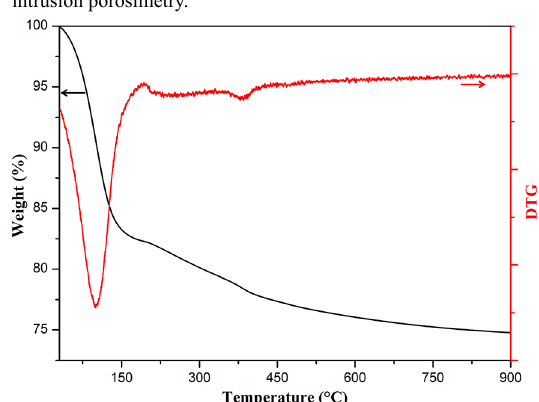
Figure 6. TG-DTG curves of unsupported silica film dried at 40